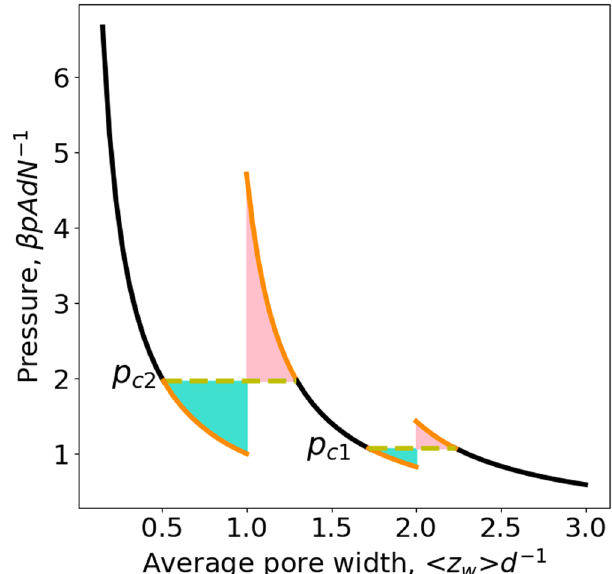
Fig. 3|Compression-expansionisothermofanidealgascon fi nedinaslit pore. Repulsive square-well gas-wall potential ( ε <0) at a reduced temperature, T =0 : 9525 ∣ ε ∣ k B (cid:1) 1 ð e βε =0 : 35 Þ . The large-pore branch is the right one giving stable states on the black part and metastable states on the orange part (above p c 1 ). The intermediate-pore branch is the middle one giving stable states on the black part and metastable states on the twoorange parts (below p c 1 or above p c 2 ).The small- pore branch is the left one giving stable states on the black part and metastable states on the orange part (below p c 2 ). The pink zone (formed by the curve corre- spondingtoover-compressedmetastablestatesandthehorizontalline p c 2 )hasthe equal area as the turquoise zone (formed by the curve corresponding to over- expanded metastable states and the horizontal line p c 2 ). The other pink and tur- quoise zones formed with p c 1 have also the equal area.